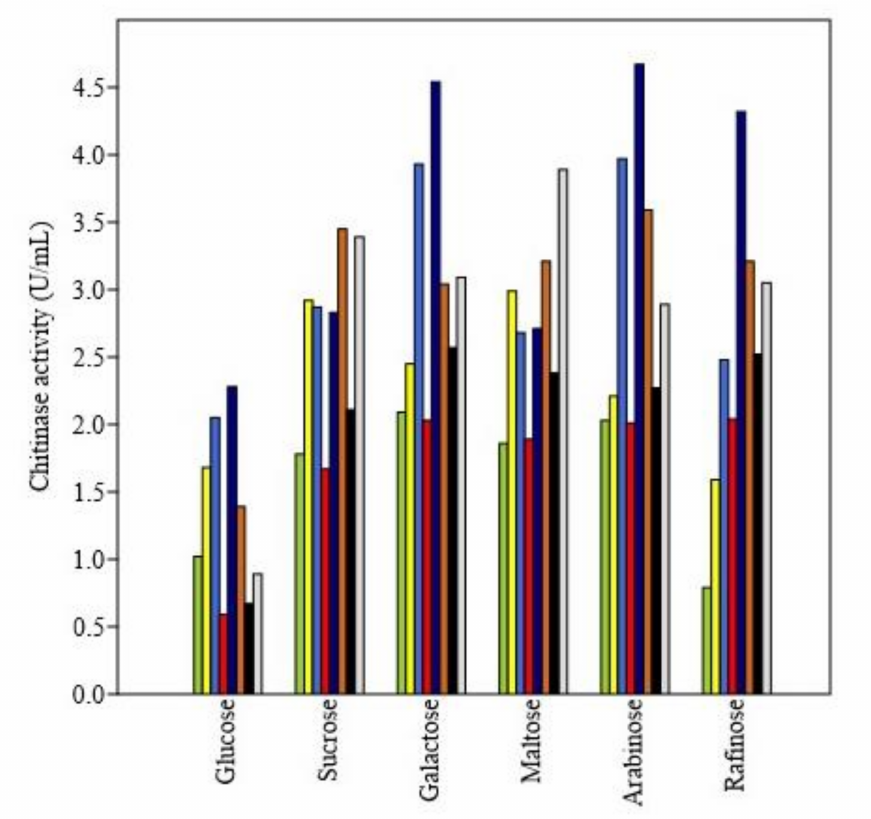
Figure 5. Effect of carbohydrate supplementations on chitinase activity. Yellow-green: AT2; Yellow: AT3; Royal blue: AT7; Red: BT1; Dark blue: BT3; Chocolate: BT4; Black: BT7 and Gainsboro: